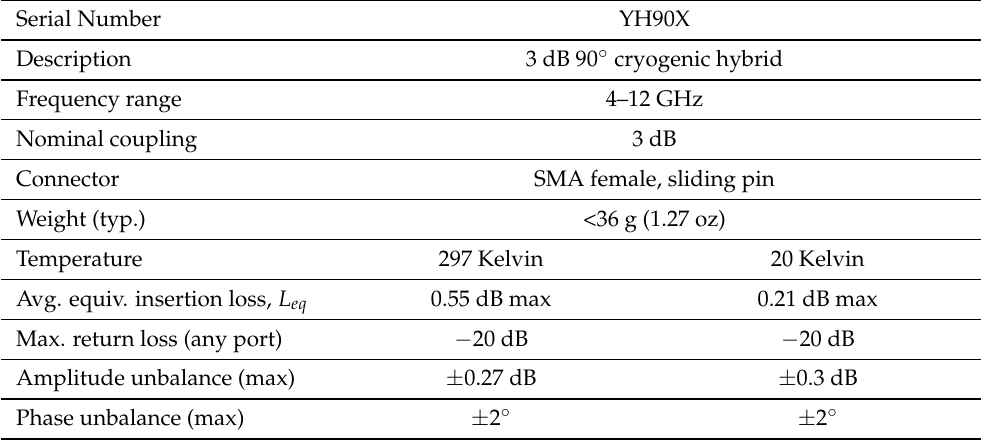
Table 2. X-band 3 dB 90 ◦ hybrid coupler performance.